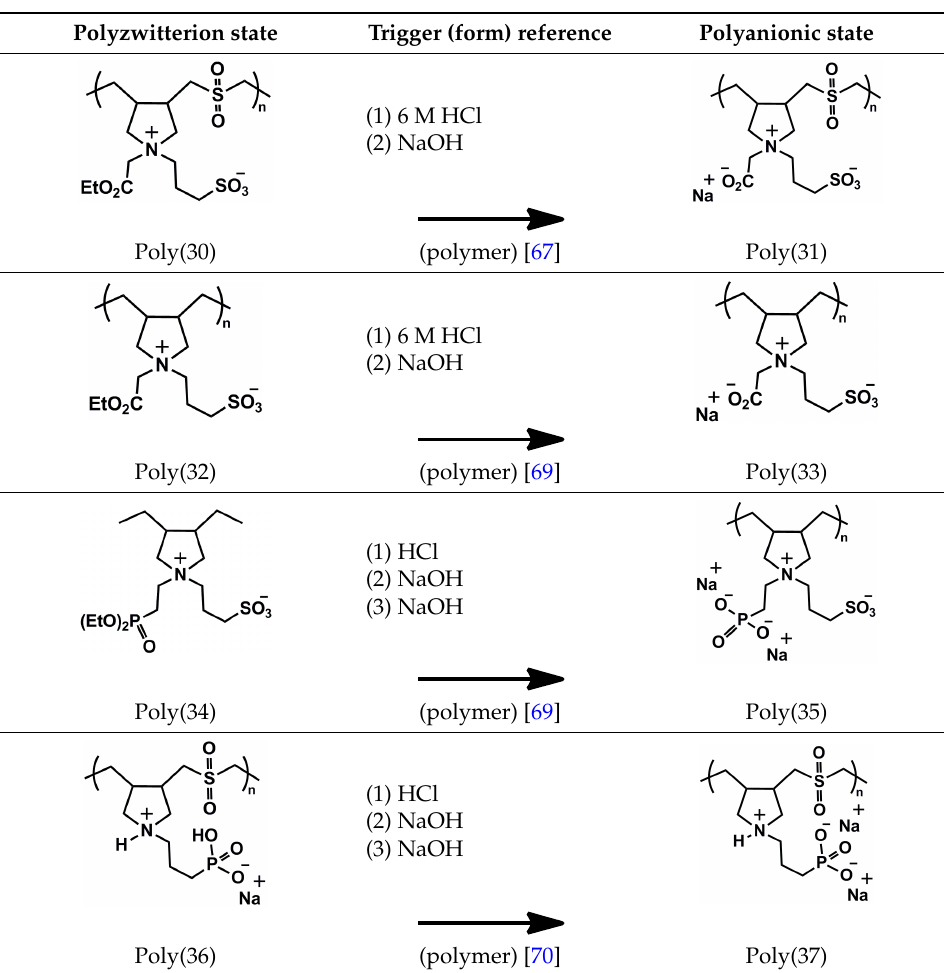
Scheme 1. Schematic presentation of irreversible and reversible switches.